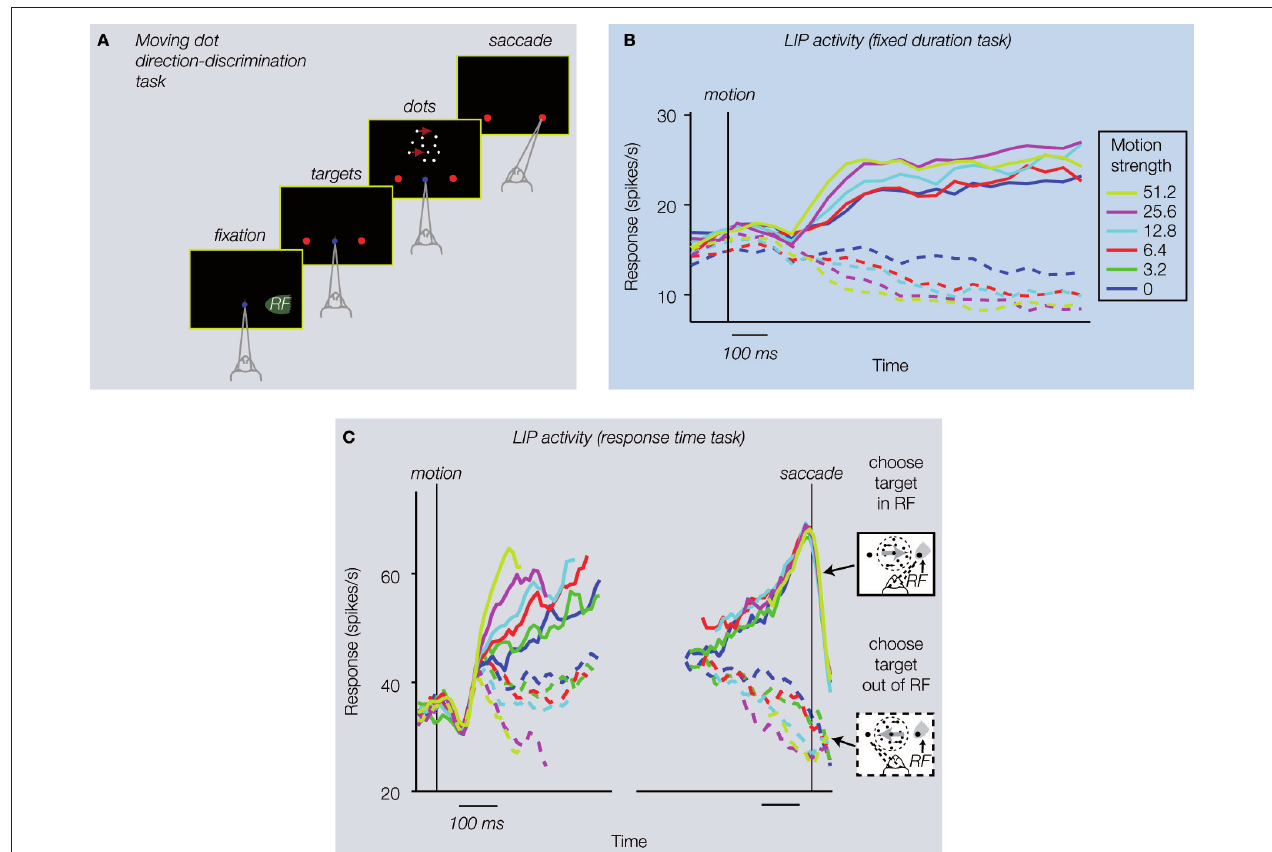
different colors indicate different motion strengths (see legend). (C) LIP activity during a response-time version of the direction discrimination task (Huk and Shadlen, 2005; Roitman and Shadlen, 2002). Monkey views dots until they have made their decision, at which point they can interrupt dot viewing by making a saccadic eye movement. This provides a measure of the decisions accuracy (correct or incorrect) as well as the time it took. Left panel, LIP response as a function of time relative to the onset of the moving dot display. Right panel, same LIP responses aligned to the time of the saccadic response. Otherwise same format as panel (B) . Adapted from Mazurek et al. (2003), with permission; original data from Shadlen and Newsome (2001) (B) , and Roitman and Shadlen (2002) (C)